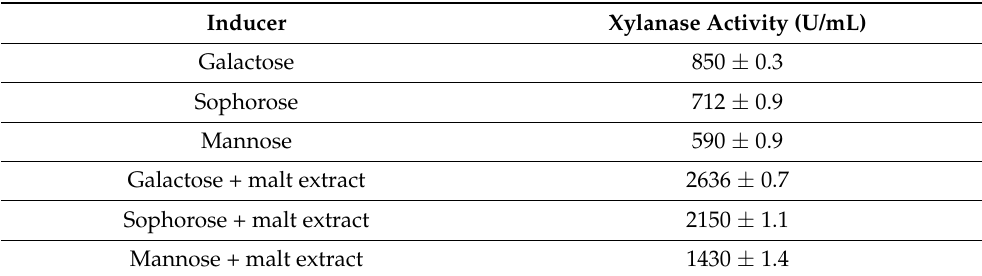
Table 2. Theeffect of different inducers on the production of xylanase by Trichoderma harzianum kj831197.1.